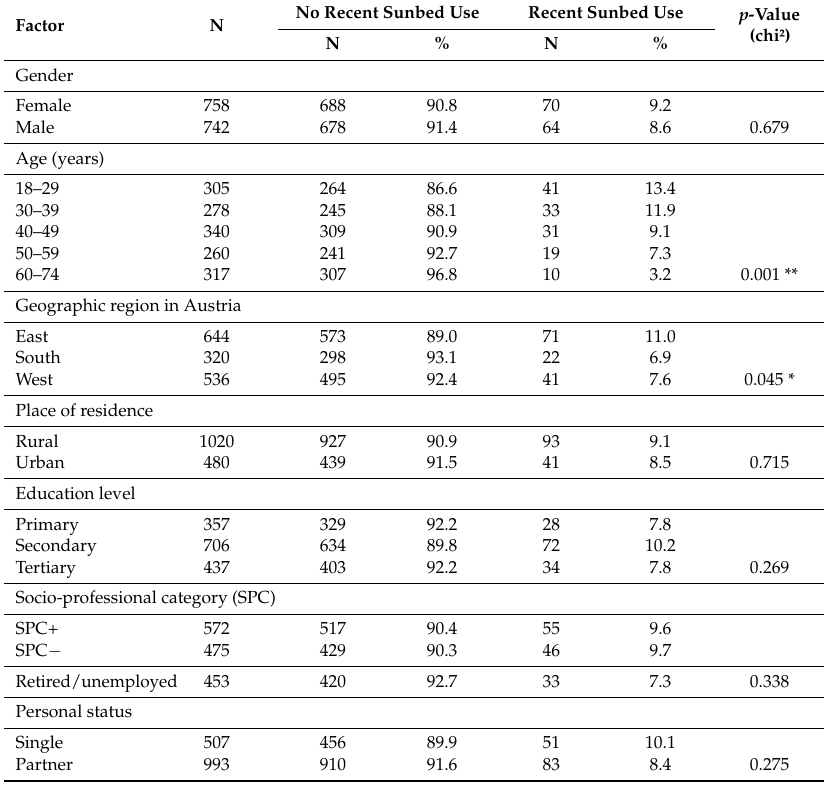
Table 2. Socio-demographic characteristics of the study population, stratified by sunbed